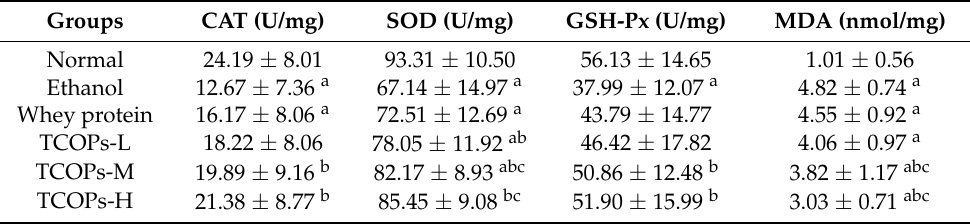
Table 5. Effects of TCOPs on antioxidant and lipid peroxidation index in duodenal tissue of rats.